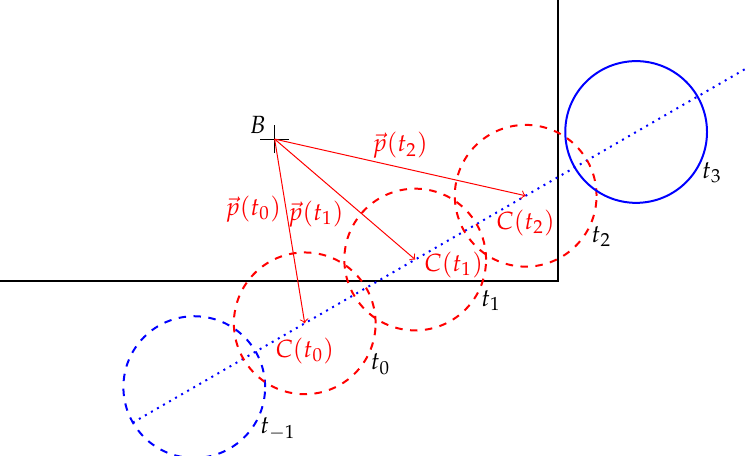
Figure 7. Example of a collision event of one arm bounding sphere and one workplace bounding box; the sphere is drawn in five simulation time steps: t − 1 , t 0 , . . . , t 3 . The event begins at t 0 .